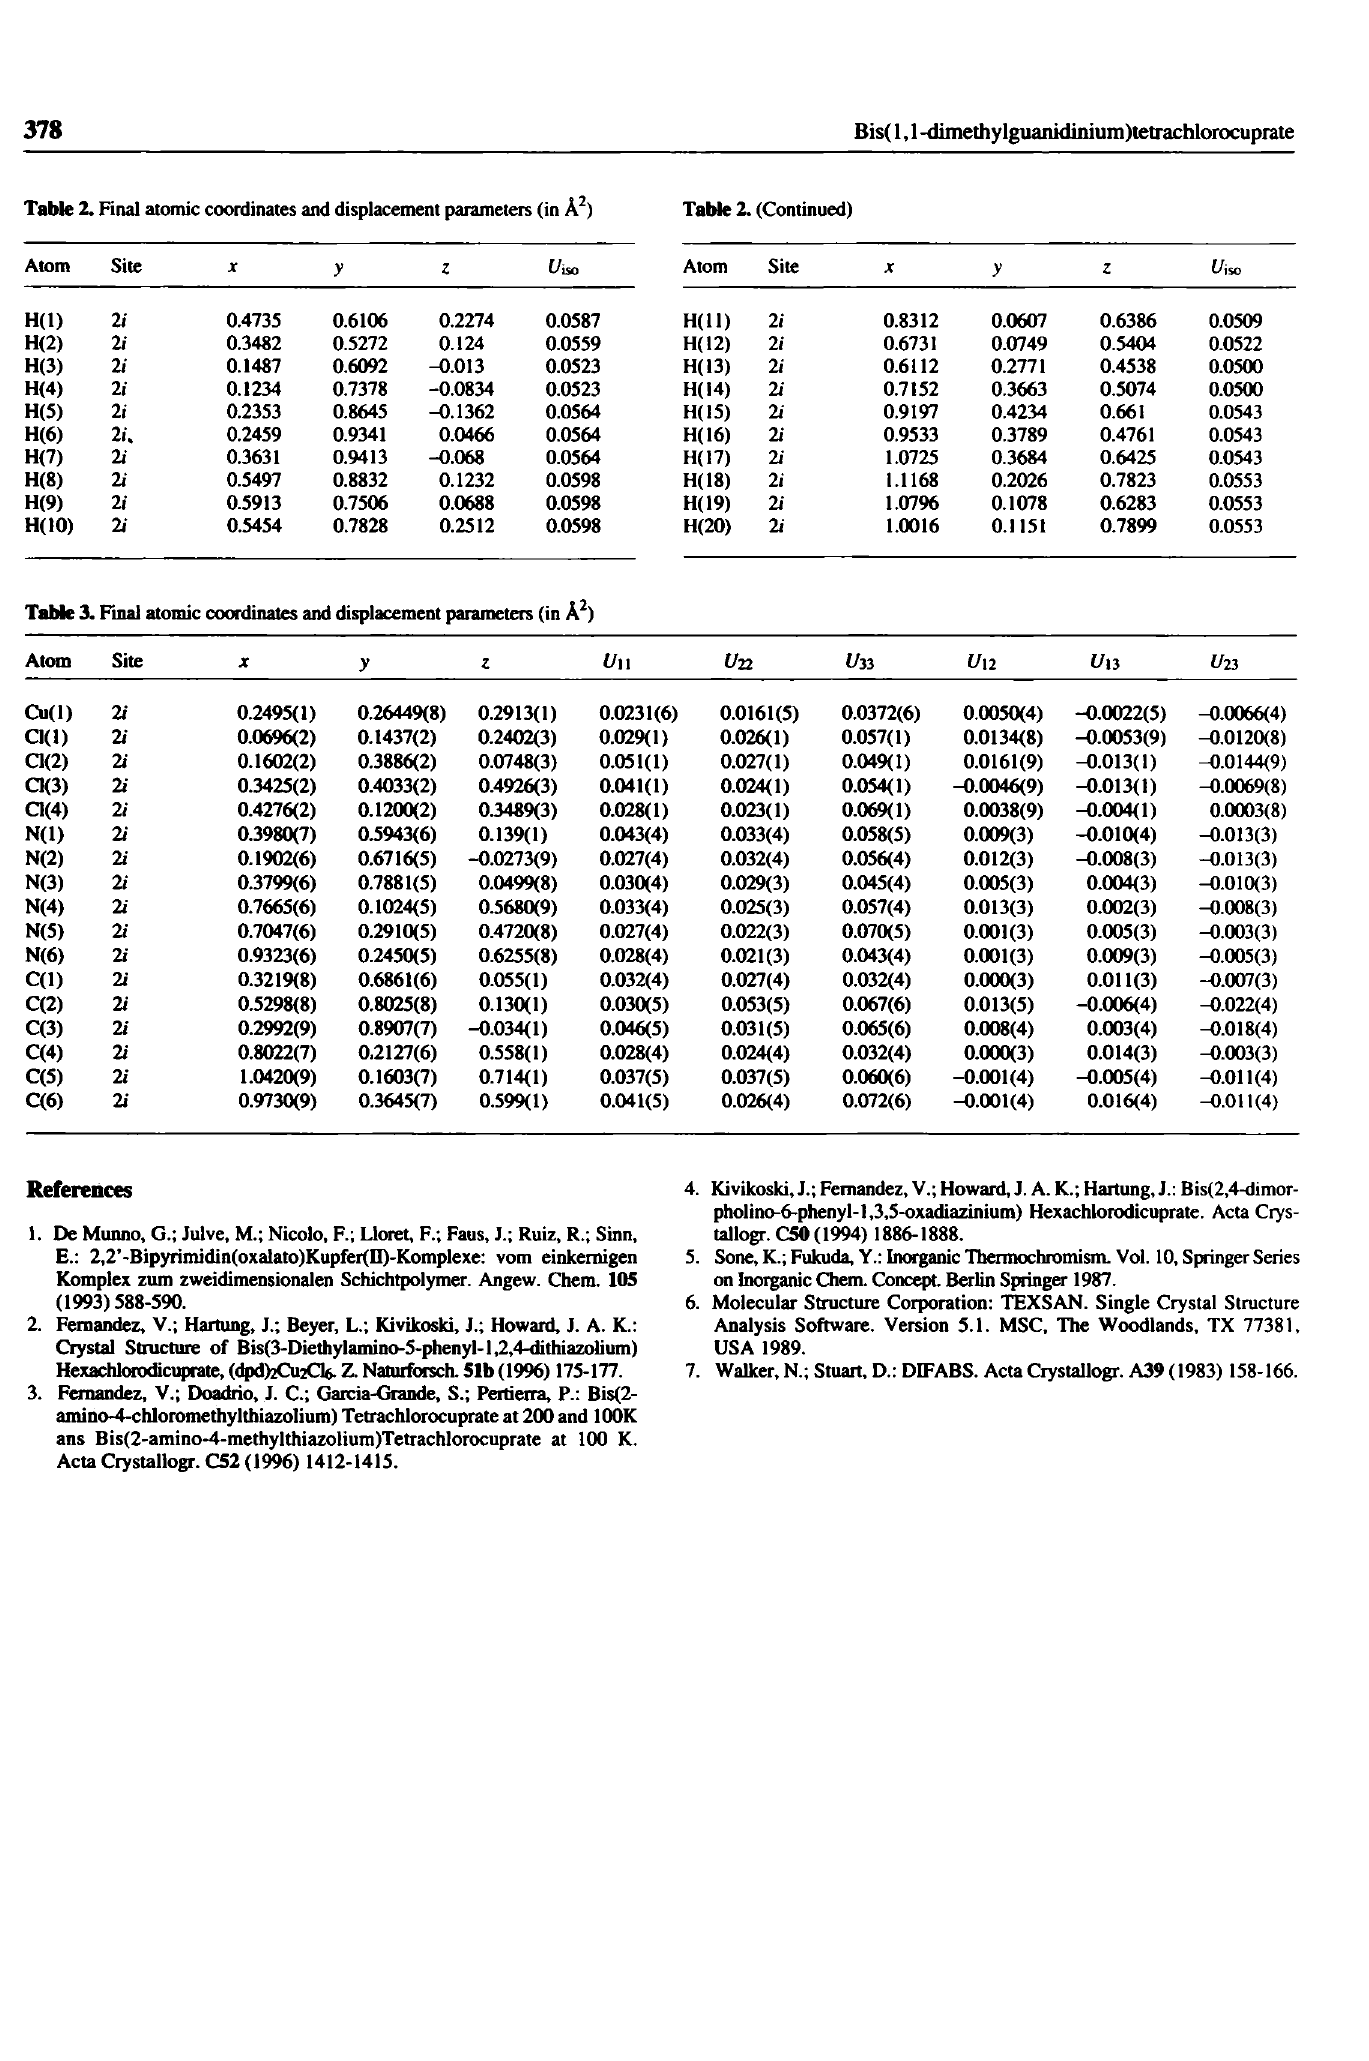
Table 3. Final atomic coordinates and displacement parameters (in Â 2